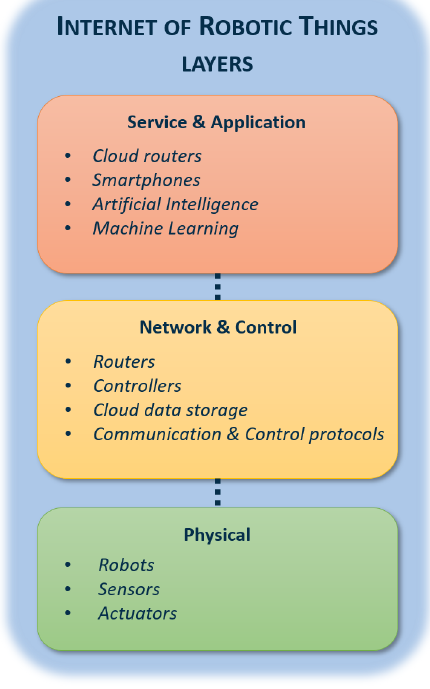
Figure 4. Schematic diagram of Internet of Robotic Things system